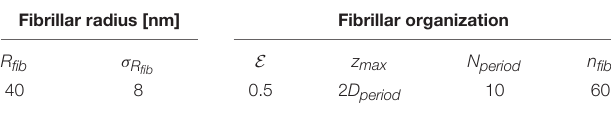
TABLE 2 | Organizational characteristics chosen for the ultrastructure of bone; in line with observations of Parry